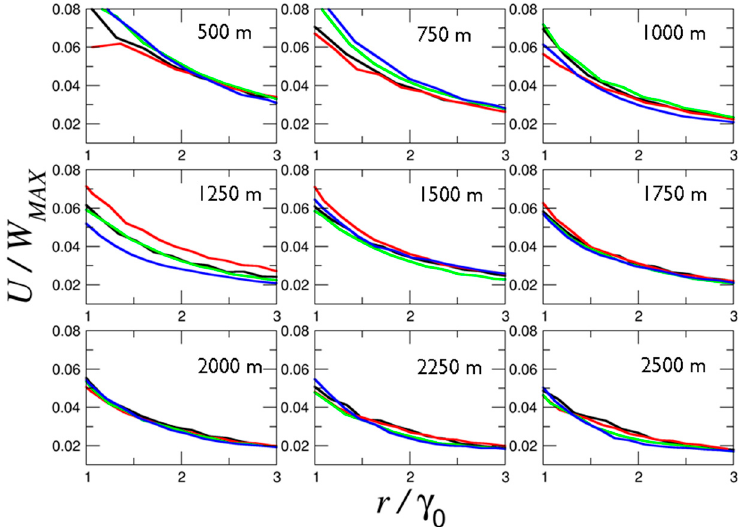
Figure 6. Radial spread against height for ( a ) 15, ( b ) 30, ( c ) 45 and ( d ) 60 min after eruption. Symbols represent vent heat fluxes of Q = 1.8 × 106 W m − 2 (circles), Q = 6.4 × 10 6 W m − 2 (diamonds), Q = 8.8 × 10 6 W m − 2 (squares), Q = 1.1 × 10 7 W m − 2 (stars). The best-line fit (see text for properties) for all the data is shown by the solid black line.